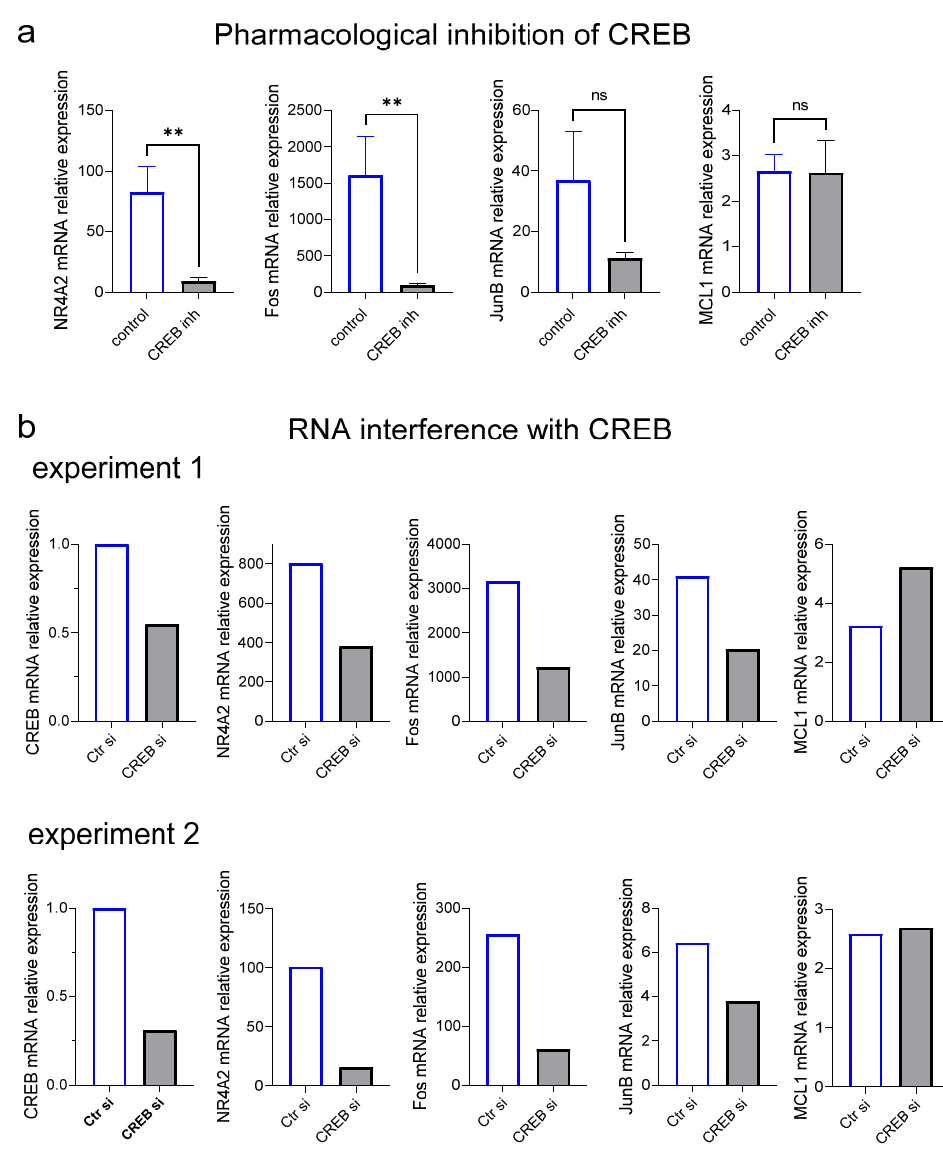
Figure 7. CREB is a critical intermediary in SCF-triggered induction of immediate-early genes but not MCL1. ( a ) Skin-derived MCs were pretreated with(out) the CREB inhibitor 666-15, then stimulated (or not) with SCF for 25 min. RT-qPCR was used to quantitate gene expression (normalized to several housekeeping genes). The fold-induction by SCF over control is depicted. Means ± SEM of eight experiments (separate cultures) for IEGs and four experiments for MCL1 are given. ** p < 0.01. ( b ) Skin-derived MCs were treated with CREB-selective versus control siRNA for 48 h, then stimulated as in ( a ) for immediate-early gene quantification. The knockdown efficiency is given on the left-hand side, which was determined in unstimulated